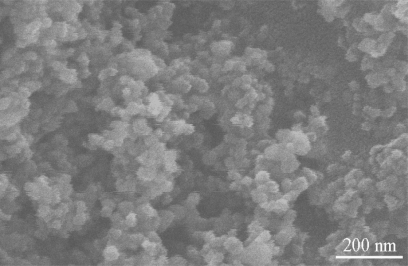
SEM image of 2.0 wt% Ag in TiO2 nanoparticles.